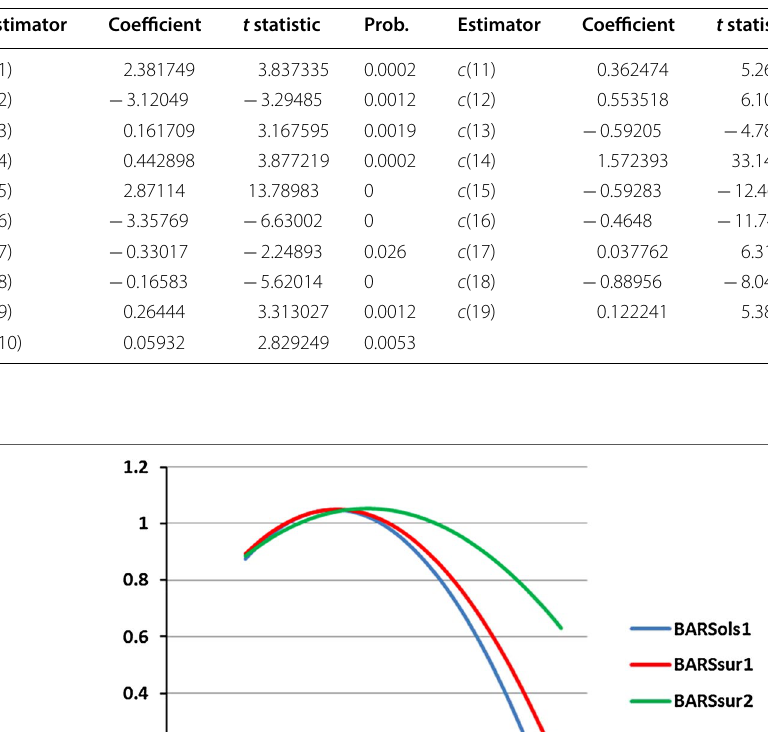
Table 3 Estimations SUR 2